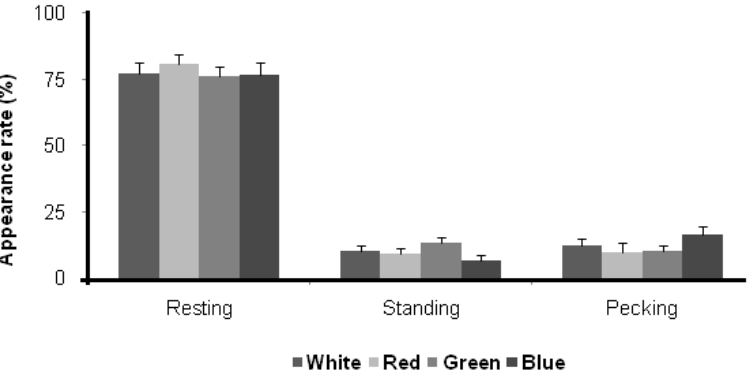
Figure 4. Behavior of broiler chickens exposed to white, red, green or blue LED lights for 2. LED, light-emitting